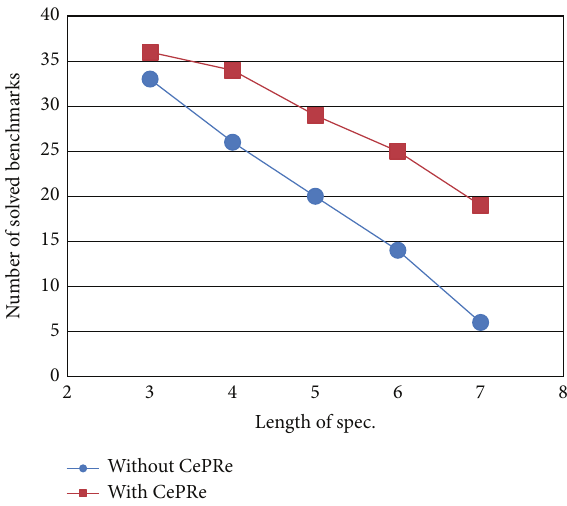
Figure 6: Experimental results of random PDR-based model